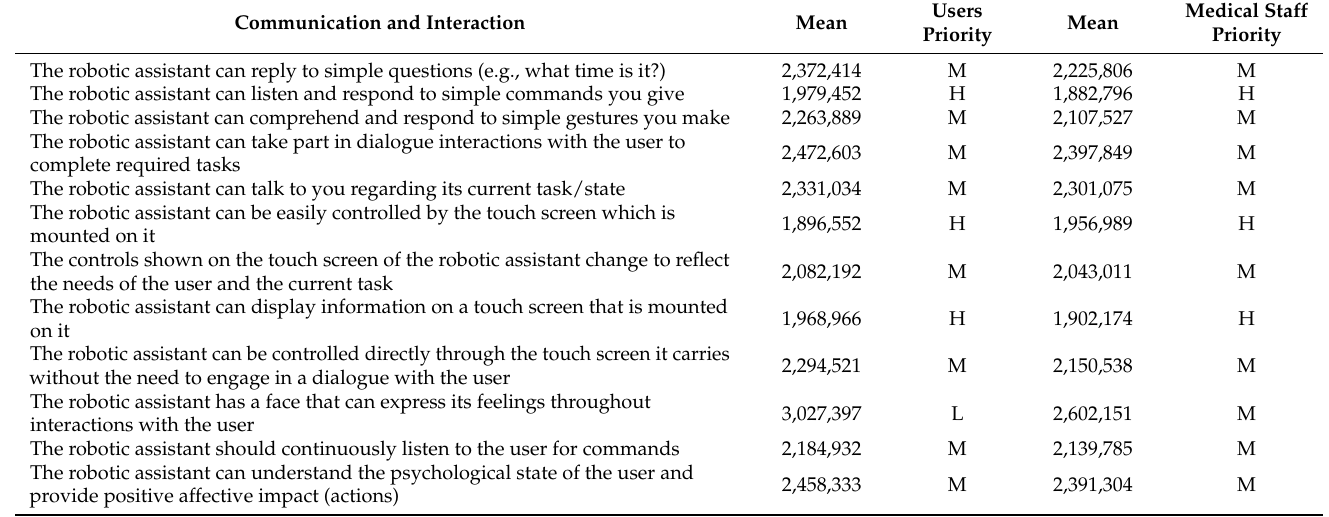
Table 4. Prioritization of different capabilities of the robotic assistant in relation to human interaction. Communication and Interaction Mean